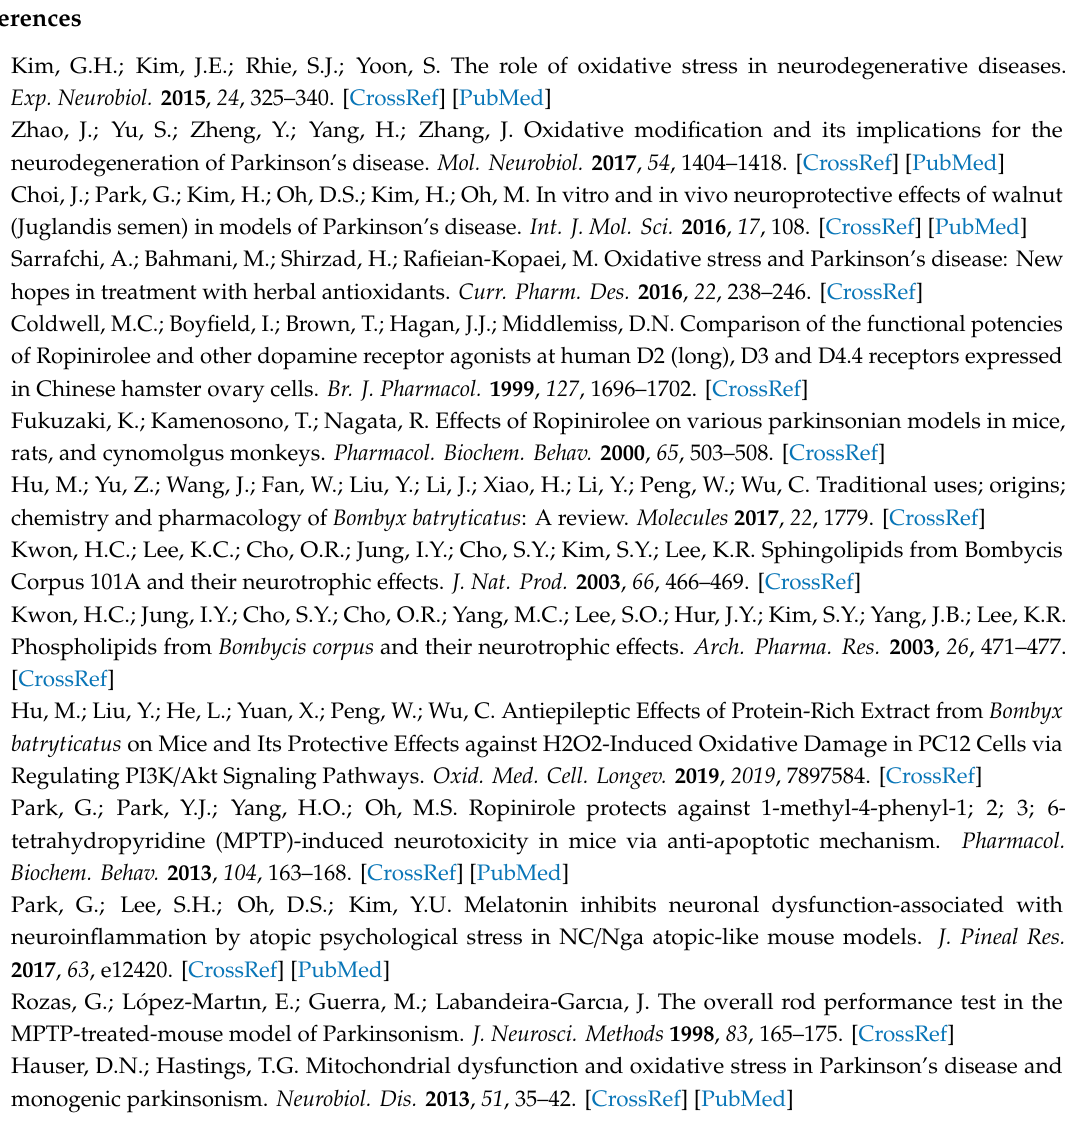
Figure S1: E ff ects of Batryticatus Bombyx (BB) on MPTP-induced dopaminergic neuronal death. Dopaminergic neurons were visualized by TH-specific immunostaining. Representative photomicrographs of the striatum (ST) were